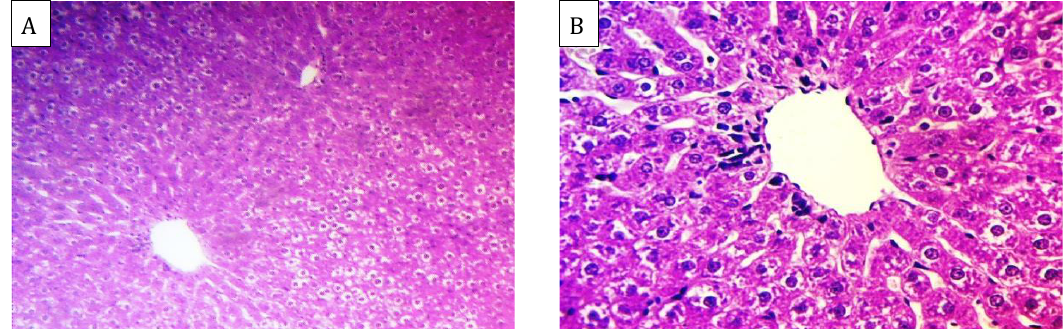
Figure 3 . Liver sections of rats fed on 1% cholesterol diet and treated orally with methanolic extract of green walnut husk, 200 mg/kg BW/day (Group 3). A: Marked cellular swelling and severe narrowing of the sinusoidsparticularly in the midzonal and periportal regions of the illustrated hepatic lobule. B: Marked cytoplasmic vacuolation of the hepatocytes and a focal infiltrate of mononuclear inflammatory cells. H&E, A: 100×, B: 400 ×